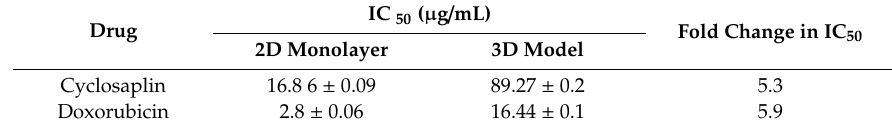
Table 1. Chemotherapeutic studies of cyclosaplin and doxorubicin.